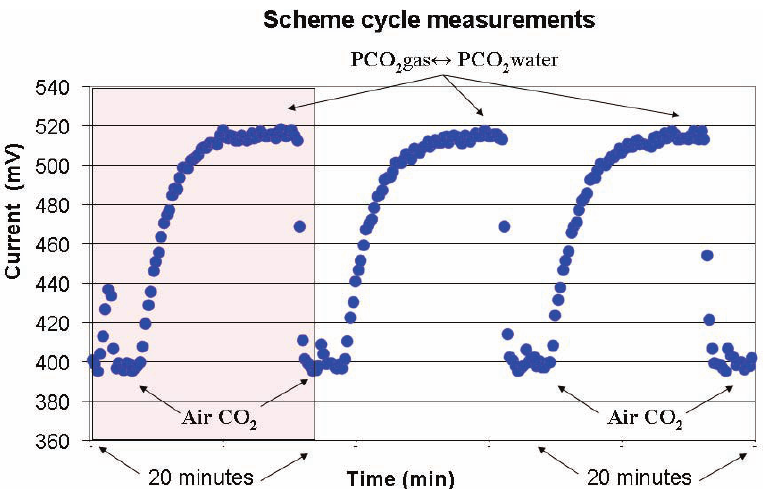
Figure 4. Example of measurement cycles of the dissolved CO is measured both before and after every cycle. Six measurement cycles were performed each day (one every 4 h).